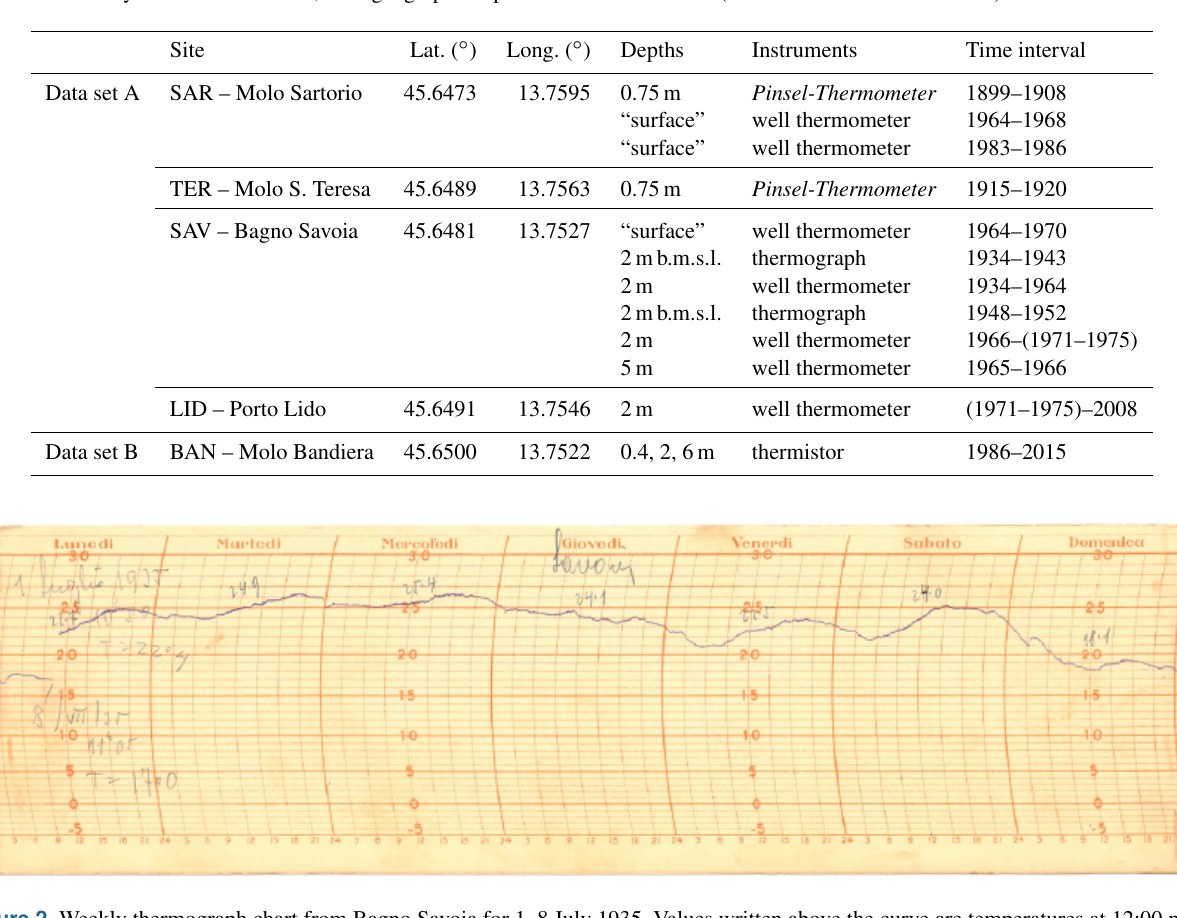
Figure 2. Weekly thermograph chart from Bagno Savoia for 1–8 July 1935. Values written above the curve are temperatures at 12:00